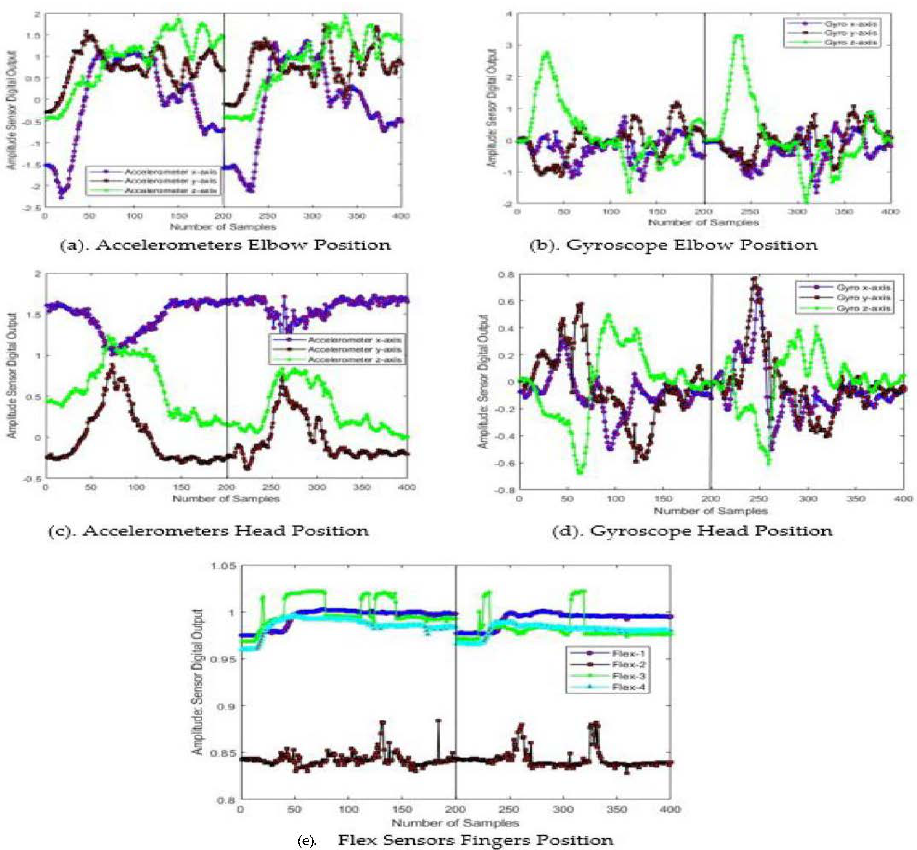
Figure 4. Two cycles of sensor response for acquiring the gesture alarm